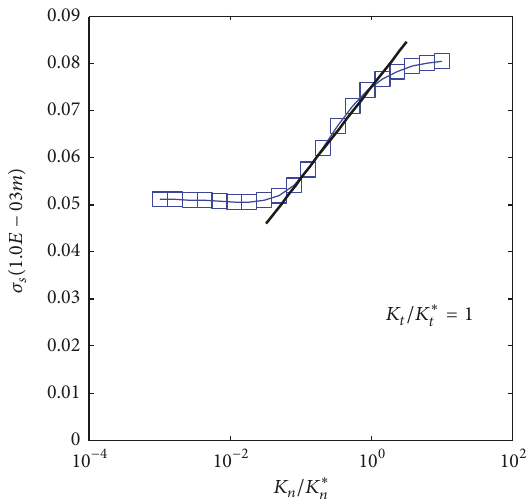
Figure 10: A schematic to define the sensitivity of 𝜎 𝑠 to 𝐾 𝑛 or 𝐾 𝑡 .